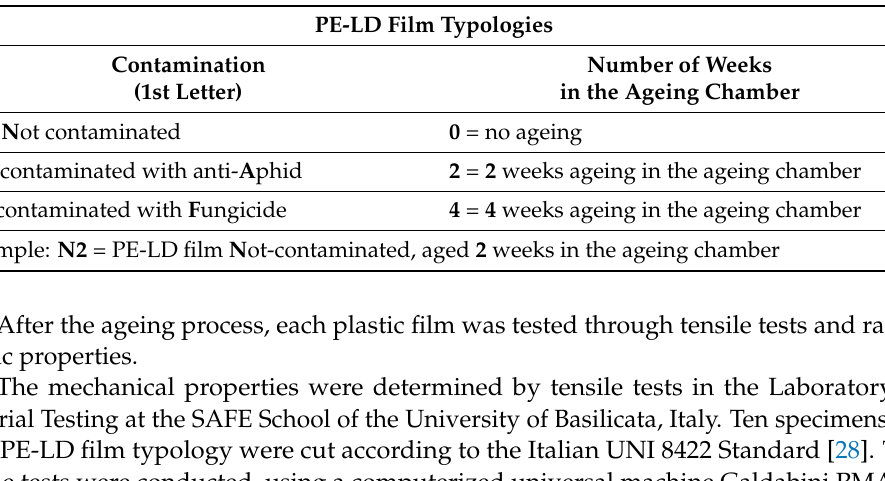
Table 1. Nomenclature of the tested PE-LD films.